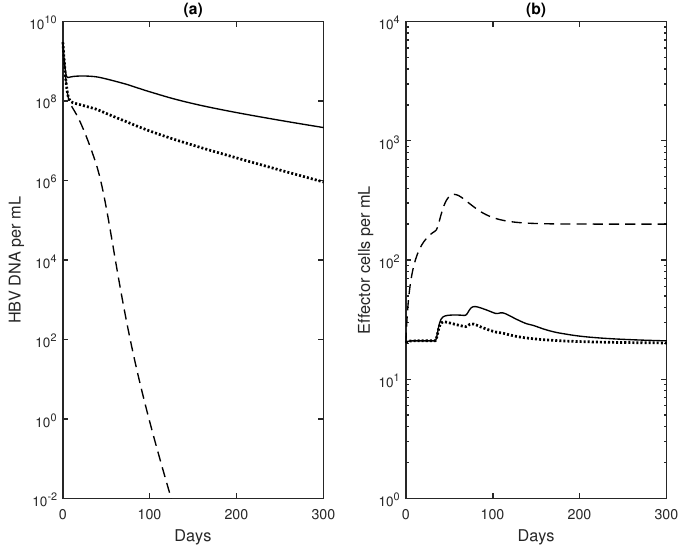
Figure 2. ( a ) Virus V per mL and ( b ) effector cells E per mL given by Model (1) and the parameters in Table 1 for: η = (cid:101) = 0 (solid lines); η = 0.5, (cid:101) = 0.9, a 1 = a 2 = a 3 = b 1 = b 2 = 1, f = 0.5 (dashed lines); and η = 0.5, (cid:101) = 0.9, a 1 = a 2 = b 1 = b 2 = 1, a 3 = 0, f = 0.5 (dotted lines). Here, time t = 0 corresponds to both the start of therapy and the peak viral load, i.e., the initial conditions are T ( 0 ) = 1.32 × 10 5 cells per mL, I ( 0 ) = 1.23 × 10 5 cells per mL, V ( 0 ) = 3 × 10 9 HBV DNA per mL, E ( 0 ) = 20.23 cells per mL and R ( 0 ) = 1.23 × 10 6 cells per